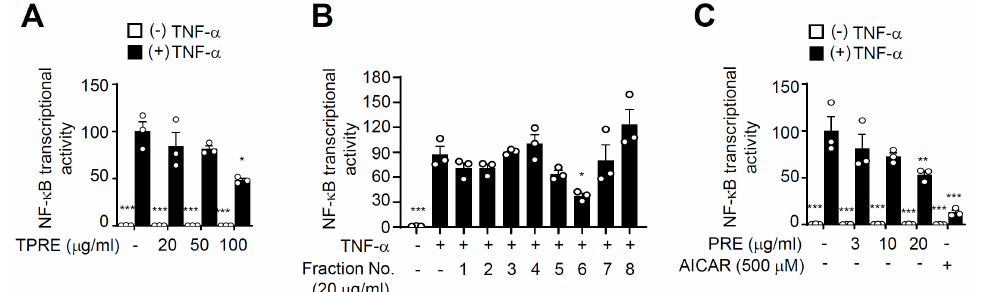
Figure 1. The effects of B. papyrifera root bark extracts on TNF- α -induced NF- κ B activity. HEK-293 cells were transfected with the NF- κ B-responsive luciferase reporter and pRL-Renilla. The cells were treated with total B. papyrifera (total B. papyrifera root bark extracts, TPRE) extracts ( A ), sub-fractions of TPRE ( B ), Sub-fraction No.6 (PRE), and 5-aminoimidazole-4-carboxamide ribonucleotide (AICAR) as the indicated concentration for 24 h ( C ), followed by treatment with TNF- α (10 ng/mL) for an additional 6 h. The cells were harvested, and luciferase activity was measured. Data are shown as the mean±S.E.M. ( n = 3 ) * p < 0.05; ** p < 0.001; *** p < 0.0001 compared to TNF- α -only-treated group.